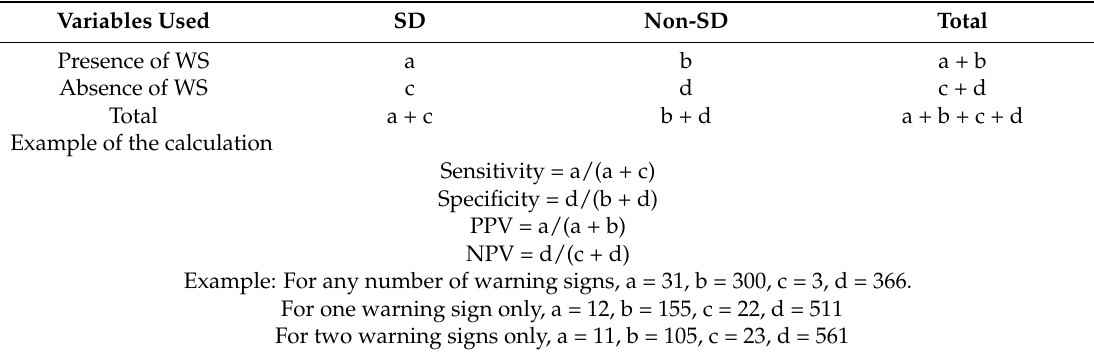
Table 1. Formula for Sensitivity, Specificity, Positive Predictive Value and Negative Predictive Value. Variables Used SD Non-SD Total Presence of WS a b a + b Absence of WS c d c + d Total a + c b + d a + b + c + d Example of the calculation Sensitivity = a/(a + c) Specificity = d/(b + d) PPV = a/(a + b) NPV = d/(c + d) Example: For any number of warning signs, a = 31, b = 300, c = 3, d =